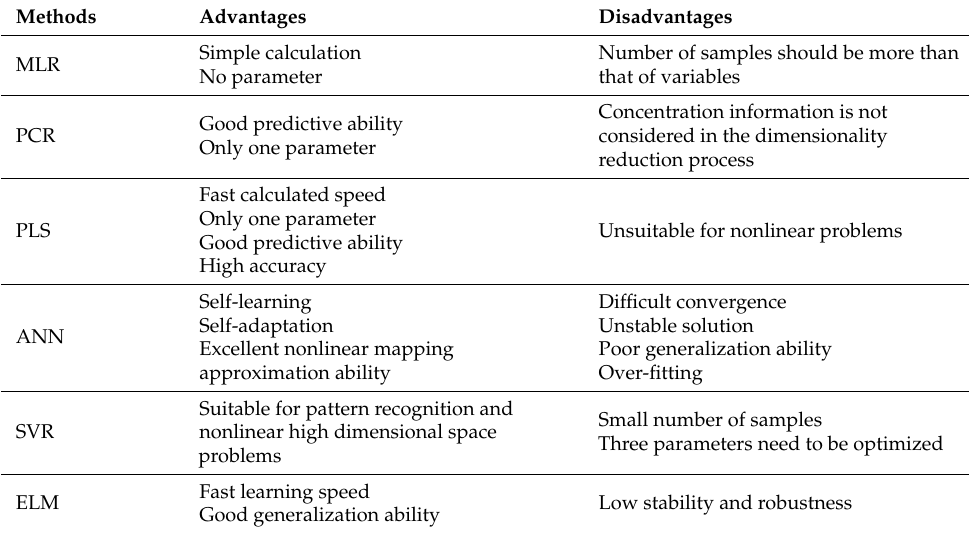
Table 4. The advantages and disadvantages of multivariate calibration methods.